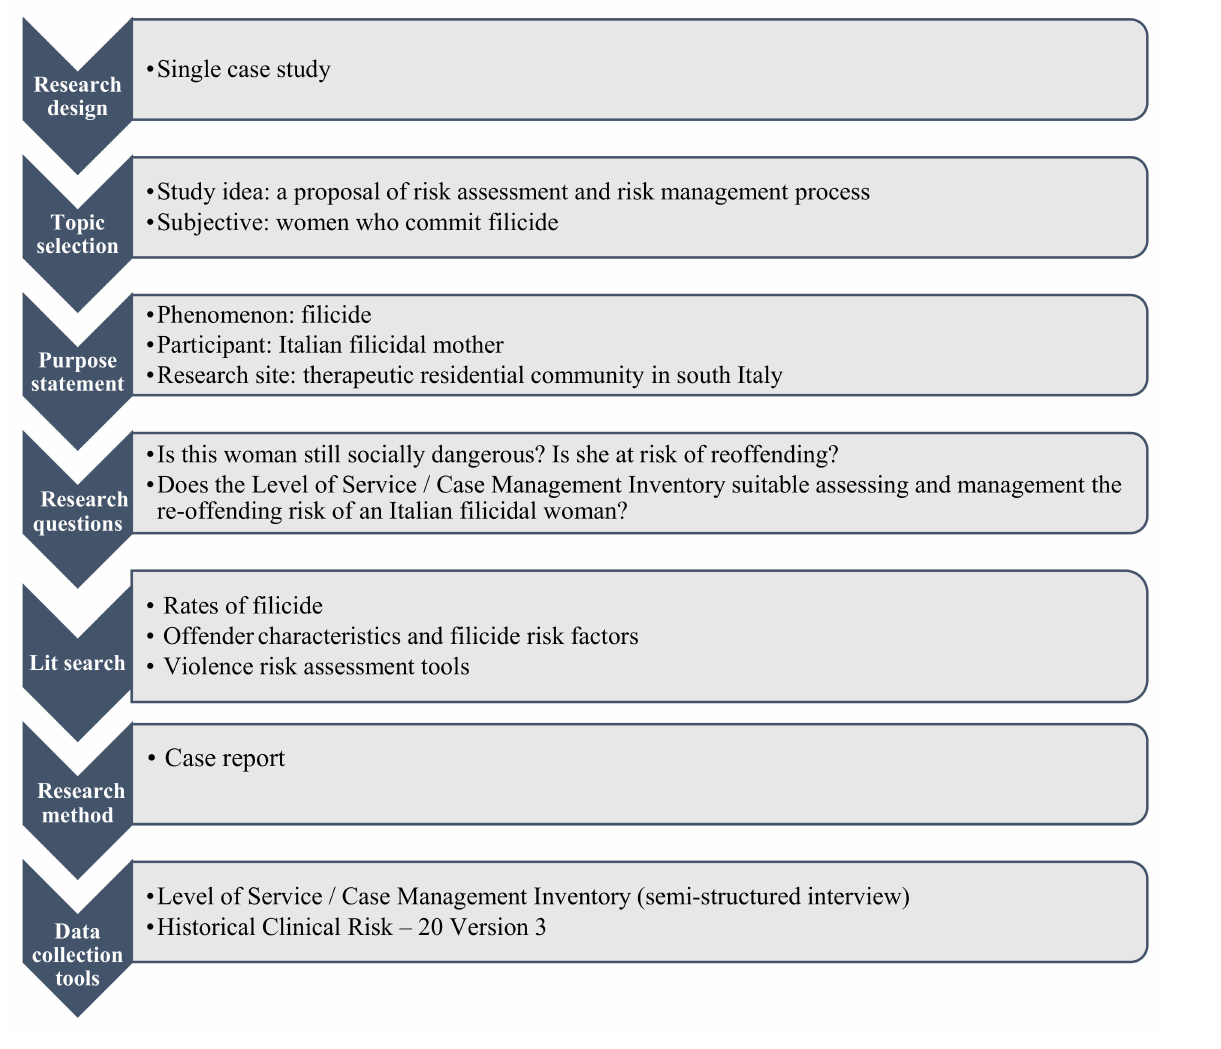
Figure A1. Roadmap of a single case